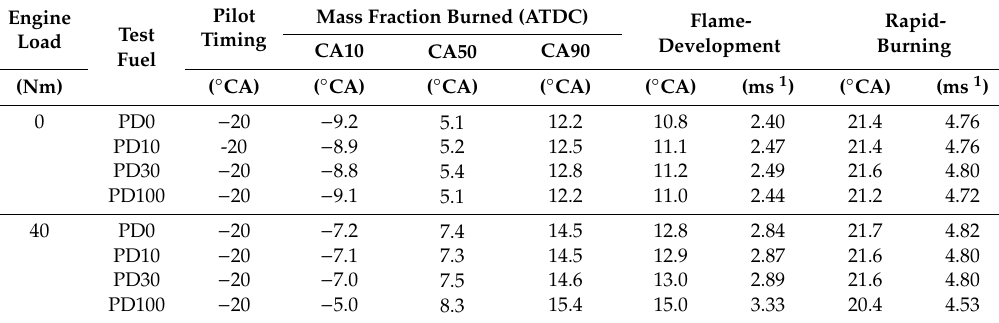
Figure 5. Mass fraction burned at engine load of ( a ) 0 Nm, ( b ) 40 Nm. Table 6. Combustion phases under test conditions.